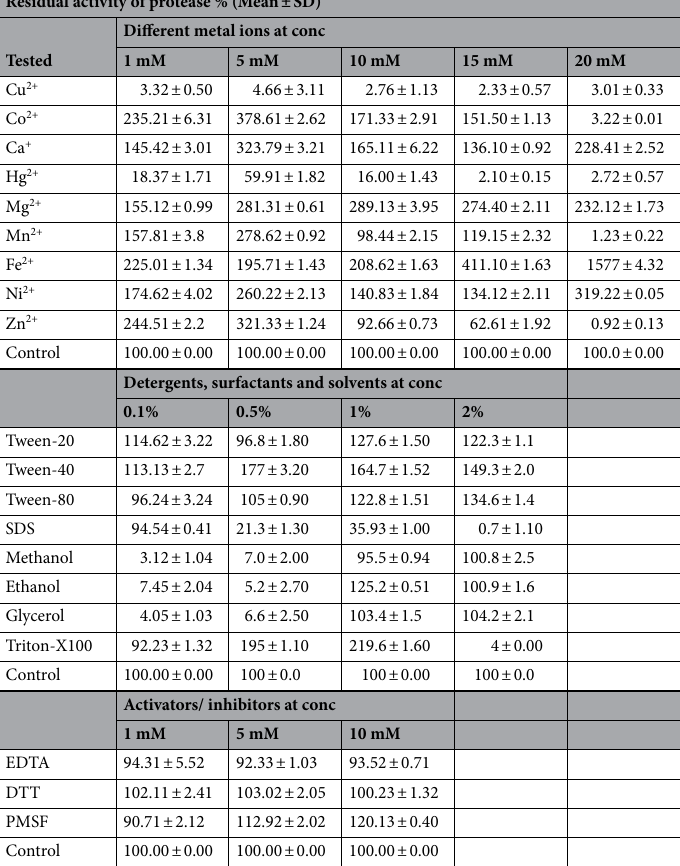
Residual activity of protease % (Mean ± SD)